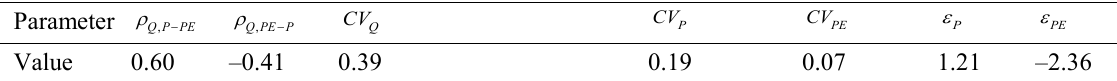
Table 2 The parameters used in equation (5) and